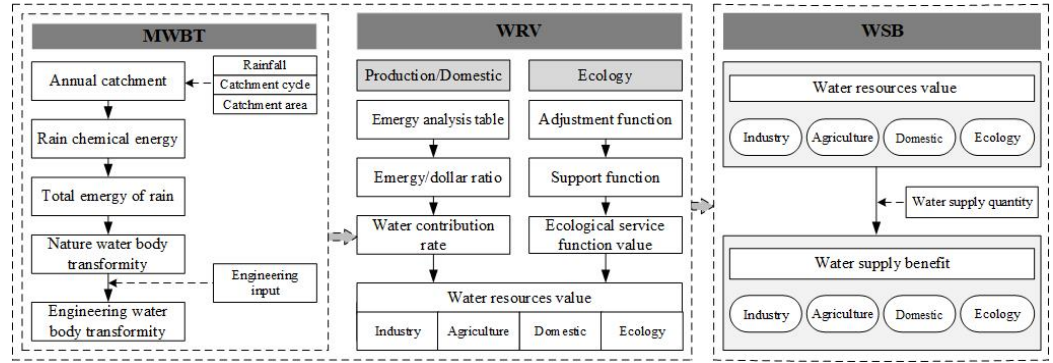
Figure 1. Structural diagram of reservoir water supply benefit assessment model.